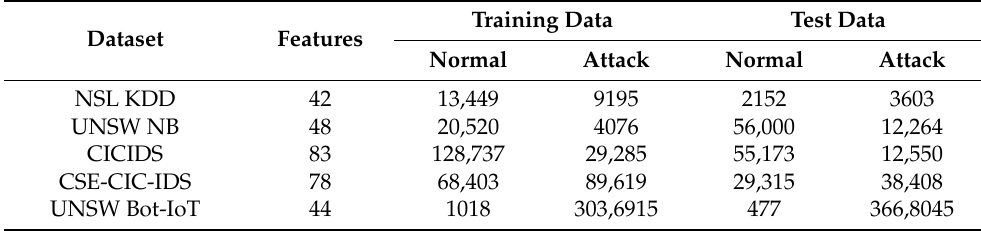
Table 1. Statistics of benchmark anomaly detection